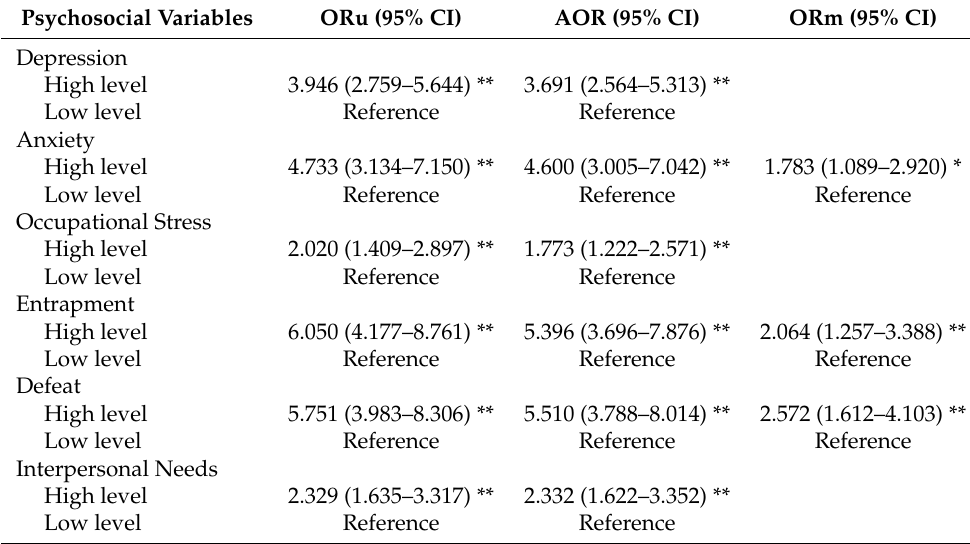
Table 3. The association between psychosocial variables and suicidal ideation.